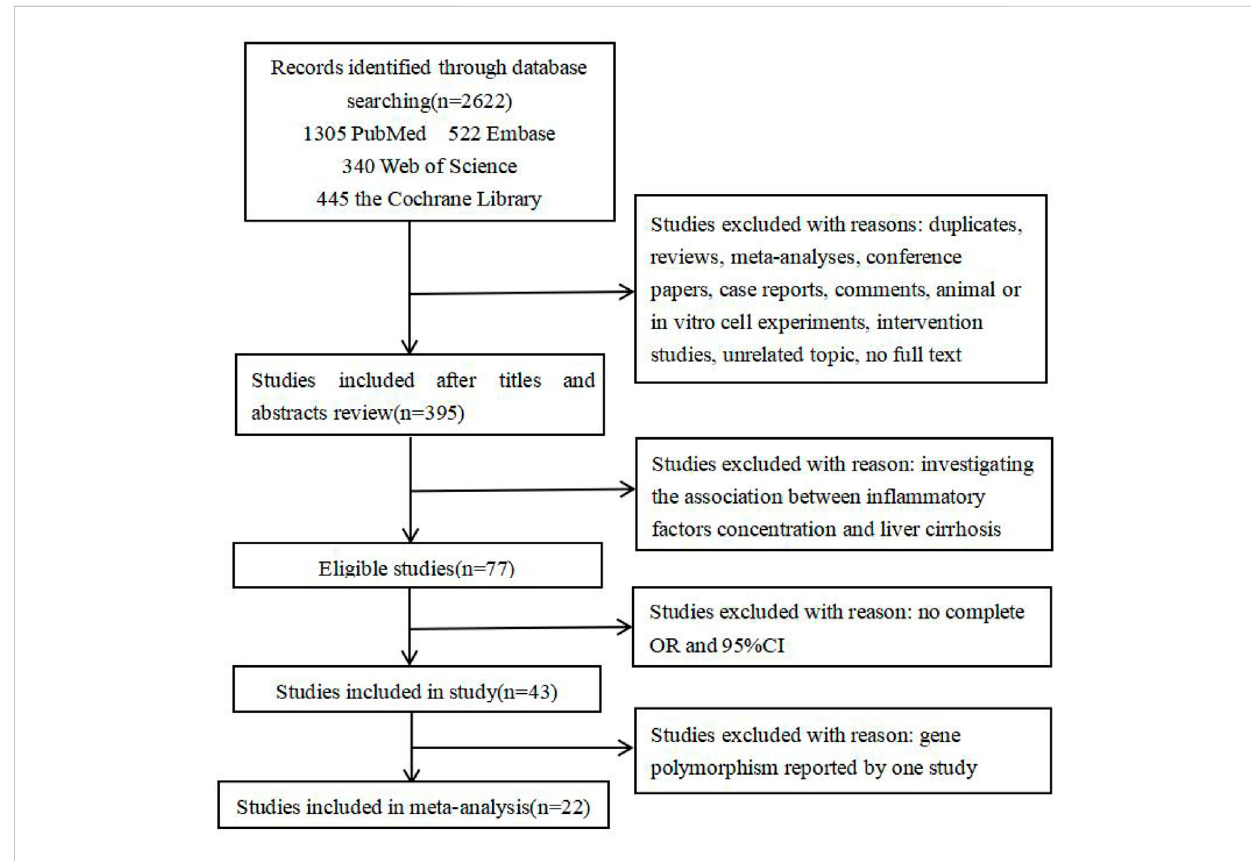
FIGURE 1 The fl owchart of study